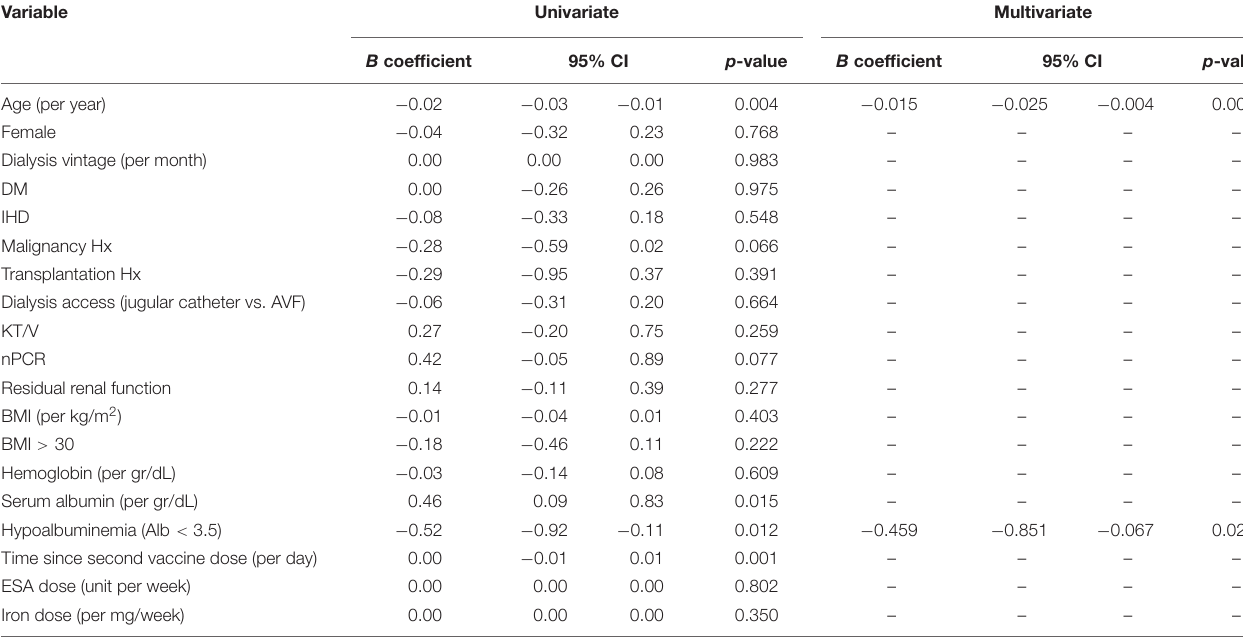
TABLE 2 | Factors associated with log-transformed anti-S1-RBD IgG titers in HD Patients. Variable